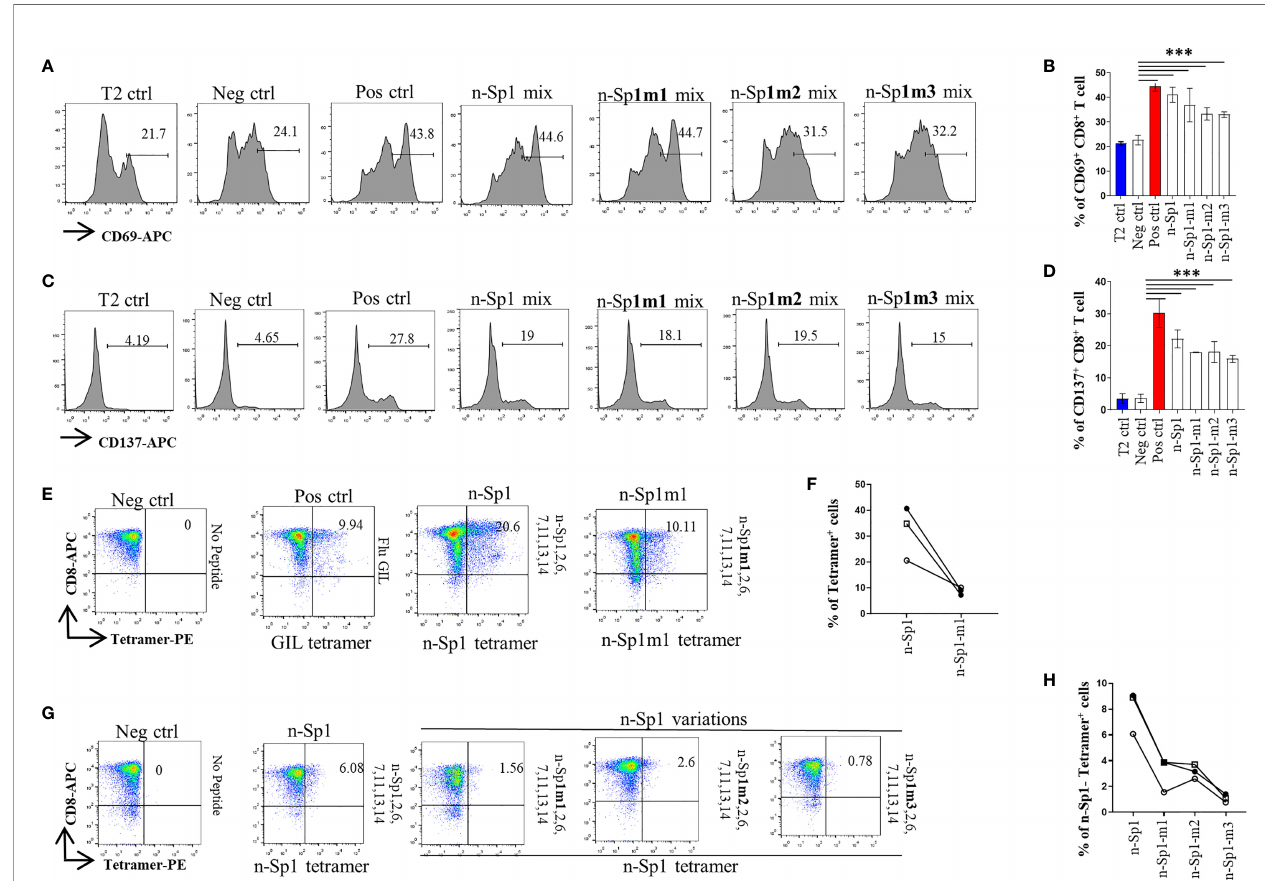
FIGURE 4 | Comparison of T-cell activation and function by n-Sp1 mutants. (A – D) Mitomycin pretreated T2 cells were loaded with n-Sp2, 6, 7, 11, 13, 14, plus n- Sp1 (n-Sp1 mix), n-Sp1m1 (n-Sp1m1 mix), n-Sp1m2 (n-Sp2 mix), or n-Sp1m3 (n-Sp3 mix) peptides, respectively. Next, pretreated T2 cells were co-cultured with CD8 + T cells from healthy donors at a 1:1 ratio. Expression level of T-cell activation marker CD69 and CD137 was evaluated with fl ow cytometry after 16 h of stimulation. (A, C) are the representative plots of data in bar graphs (B, D) , n = 4. Generation of n-Sp1- and n-Sp1m1-speci fi c CD8 + T cells in the same subjects. (E, F) The epitope-speci fi c CD8 + T cells from the same subjects were measured with corresponding epitope peptide-based tetramer after 7 days of stimulation. (E) is the representative plot for (F) . (G, H) The epitope simulation condition and tetramer information are labeled above and below the dot plot, respectively. n = 3. n-Sp1 tetramer could not recognize mutant-stimulated CD8 + T cells in the same subjects. n-Sp1 tetramer was used to stain n-Sp1 or n-Sp1 mutant peptide- stimulated CD8 + T cells from the same subjects after 7 days. (G) is the representative plot for (H) . The epitope simulation condition and the tetramer information were labeled above and below the dot plot, respectively. n = 3. T2 ctrl: T2 cells without peptide loading; Neg ctrl: T2 cells loaded with Zika virus peptide P30-38 GLQRLGYVL; Pos ctrl: T2 cells loaded with in fl uenza A M1 peptide M58-66 GILGFVFTL. The data are represented as the mean ± SD in three independence experiments, *** p ≤